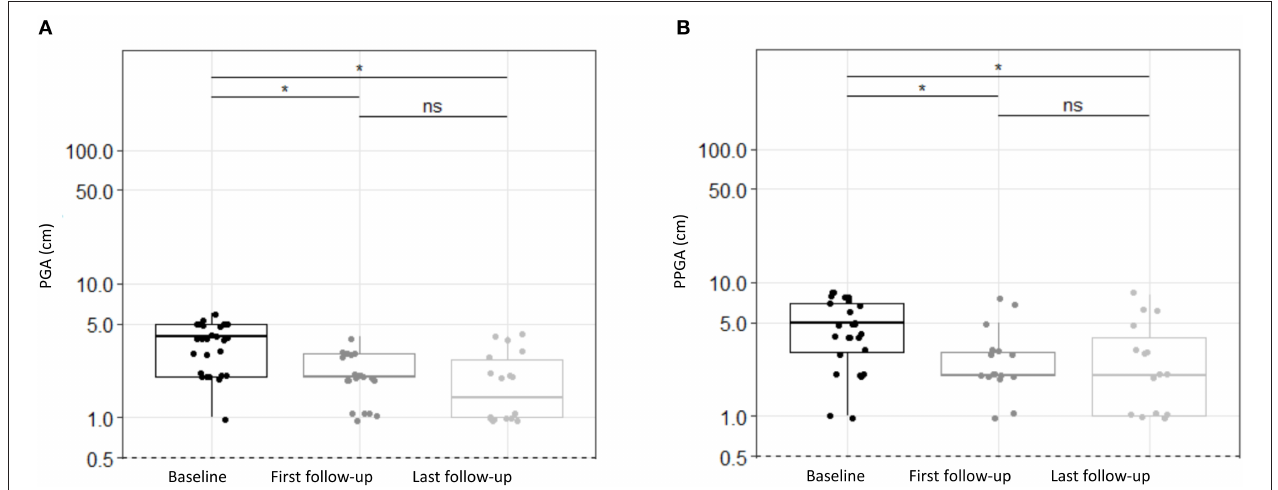
TABLE 2 | Disease activity, flare characteristics, and colchicine effectiveness of 27 PFAPA patients treated with colchicine. Disease activity